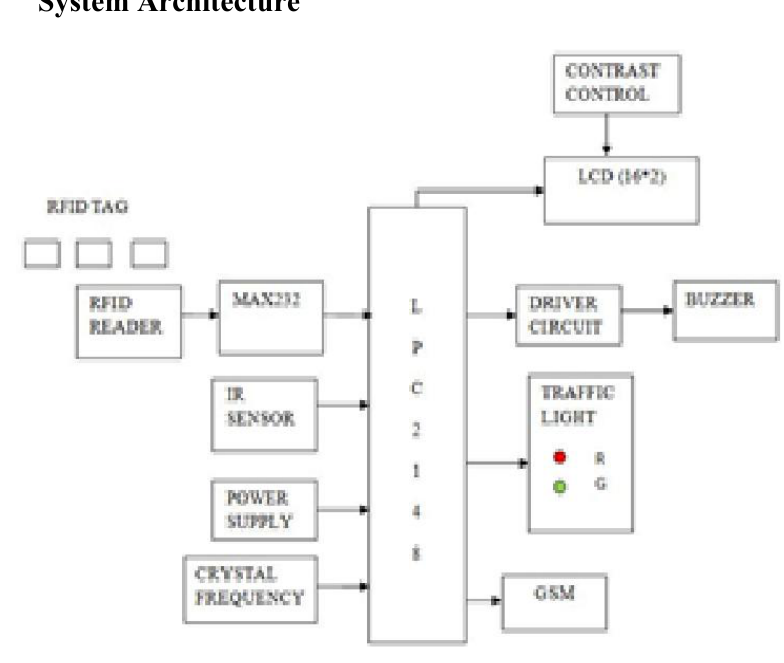
Fig. 2. Block Diagram of Proposed System